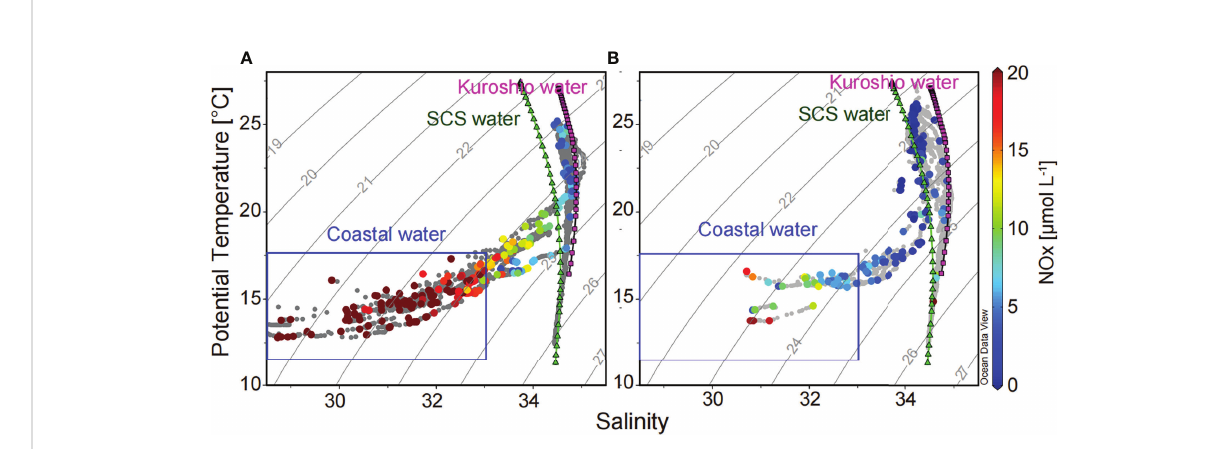
FIGURE 5 Potential temperature-salinity diagrams during the observations in 2016 (A) and 2018 (B) . Grey points represent all data of temperature and salinity in the water column, and color points represent the NO X concentrations in the sampling layer.